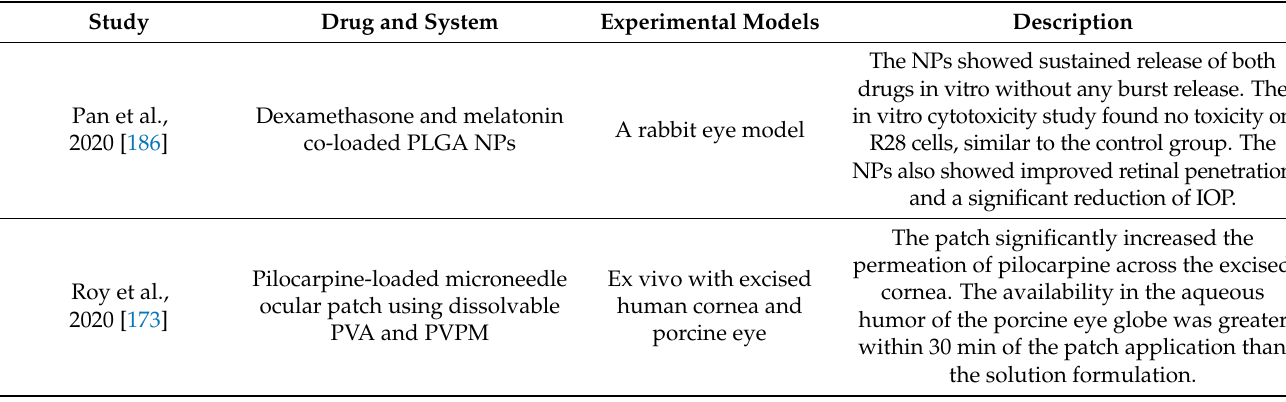
Table 4. Studies of biodegradable formulations for